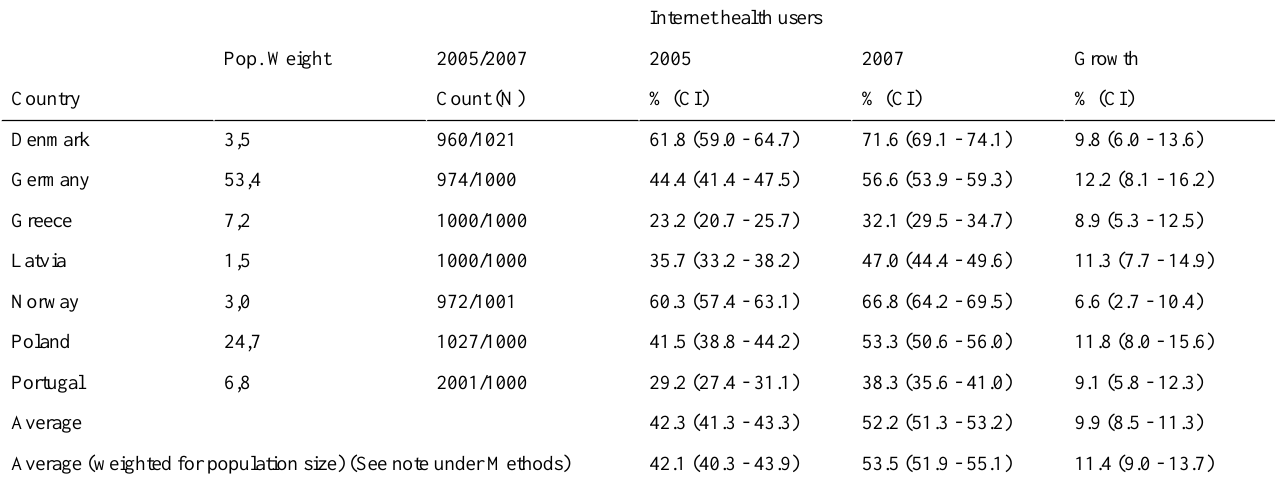
Table 1. Internet health users in the seven European countries—trends 2005 and 2007 (an expanded version that also includes Internet users is available as Multimedia Appendix